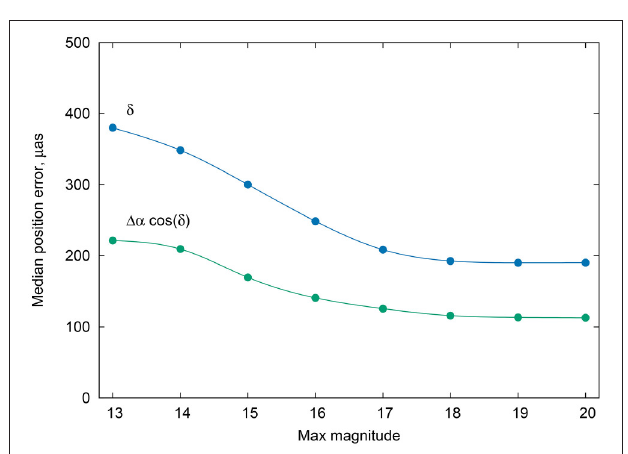
FIGURE 5 | Median errors of the gsf2015b positions depending on source selection based on the faint-end optical magnitude threshold.